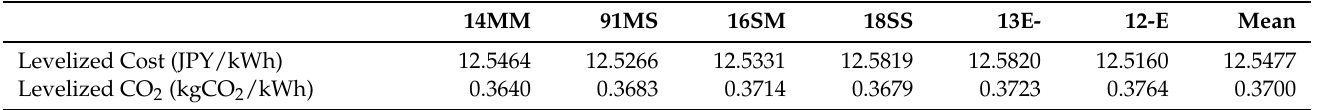
Table 9. Cost and CO 2 emissions of the reference